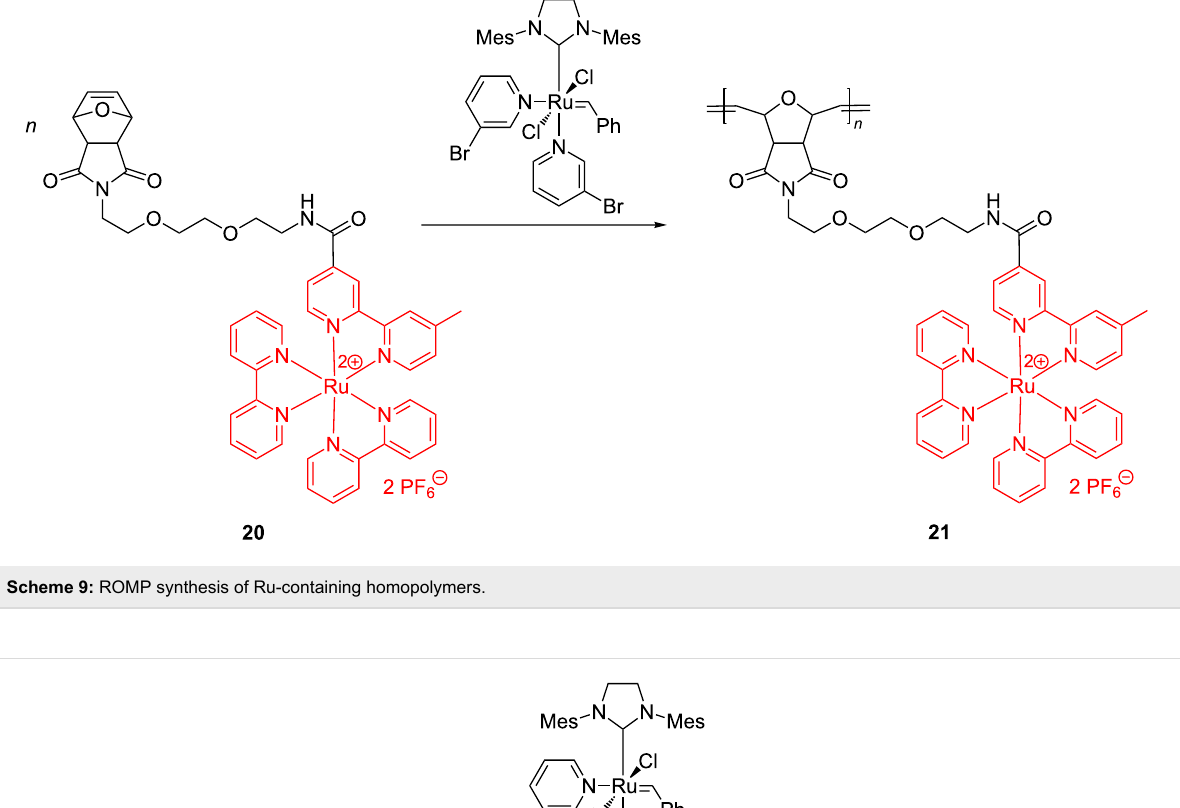
Scheme 9: ROMP synthesis of Ru-containing homopolymers.